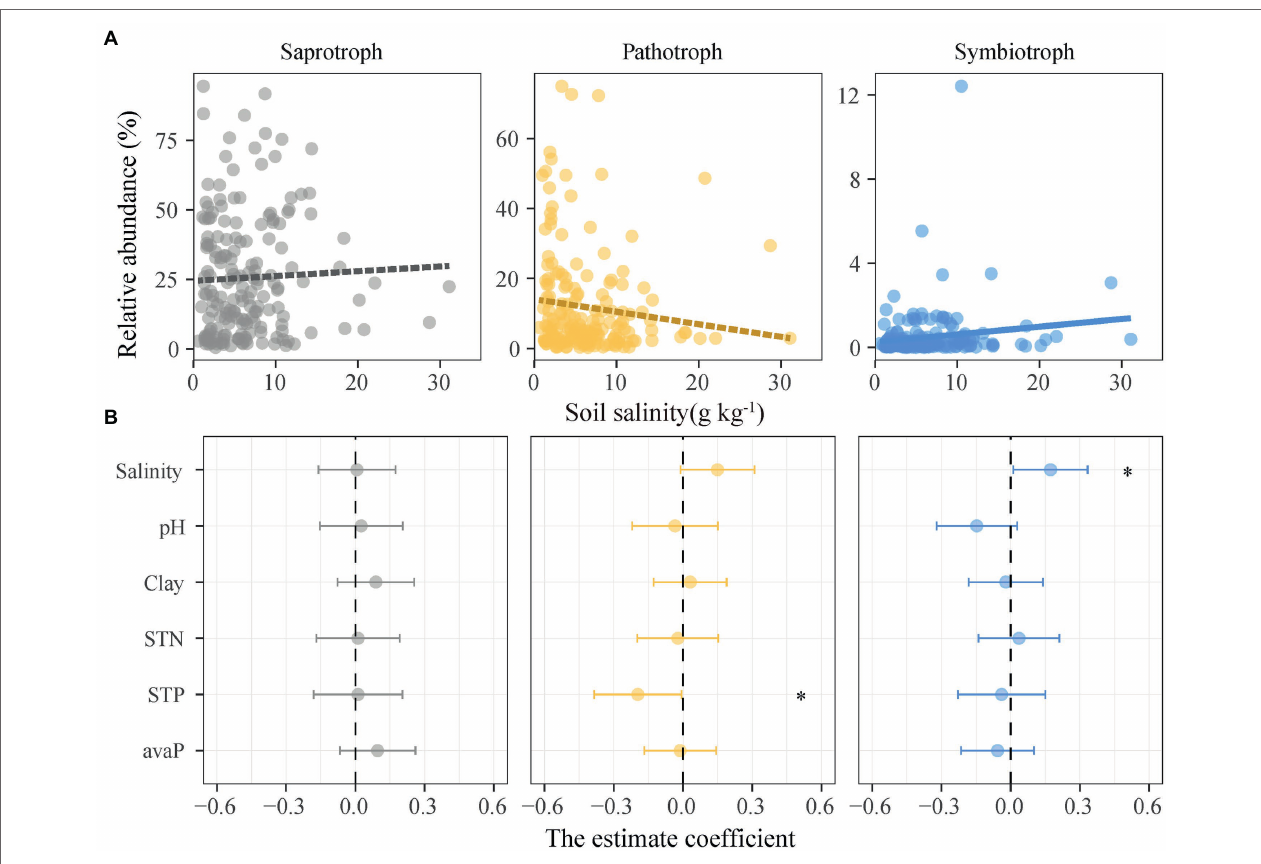
FIGURE 2 | Relationships between the relative abundance of functional guilds of soil fungi and soil salinity and properties. (A) Lines are derived from the linear mixed effects models, and solid and dashed lines denote significant and insignificant regression coefficients, respectively. (B) Points denote regression coefficients and error bars denote 95% confidence intervals. * p < 0.05. Abbreviations: Salinity, soil salinity; STN, soil total nitrogen; Clay, soil clay content; STP, soil total phosphorus; avaP, soil available